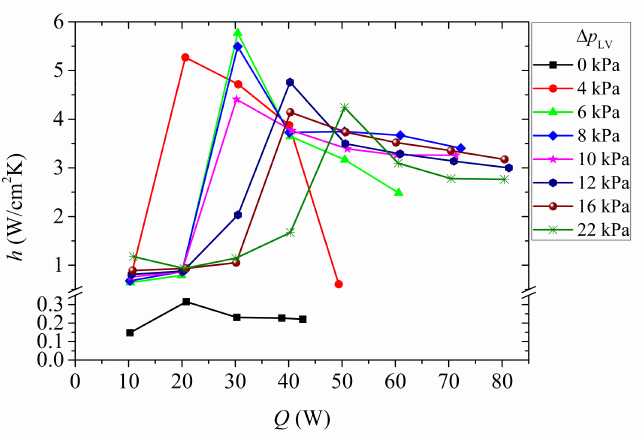
Figure 5. Variation in heat transfer coefficient under different liquid-vapor pressure difference and heating